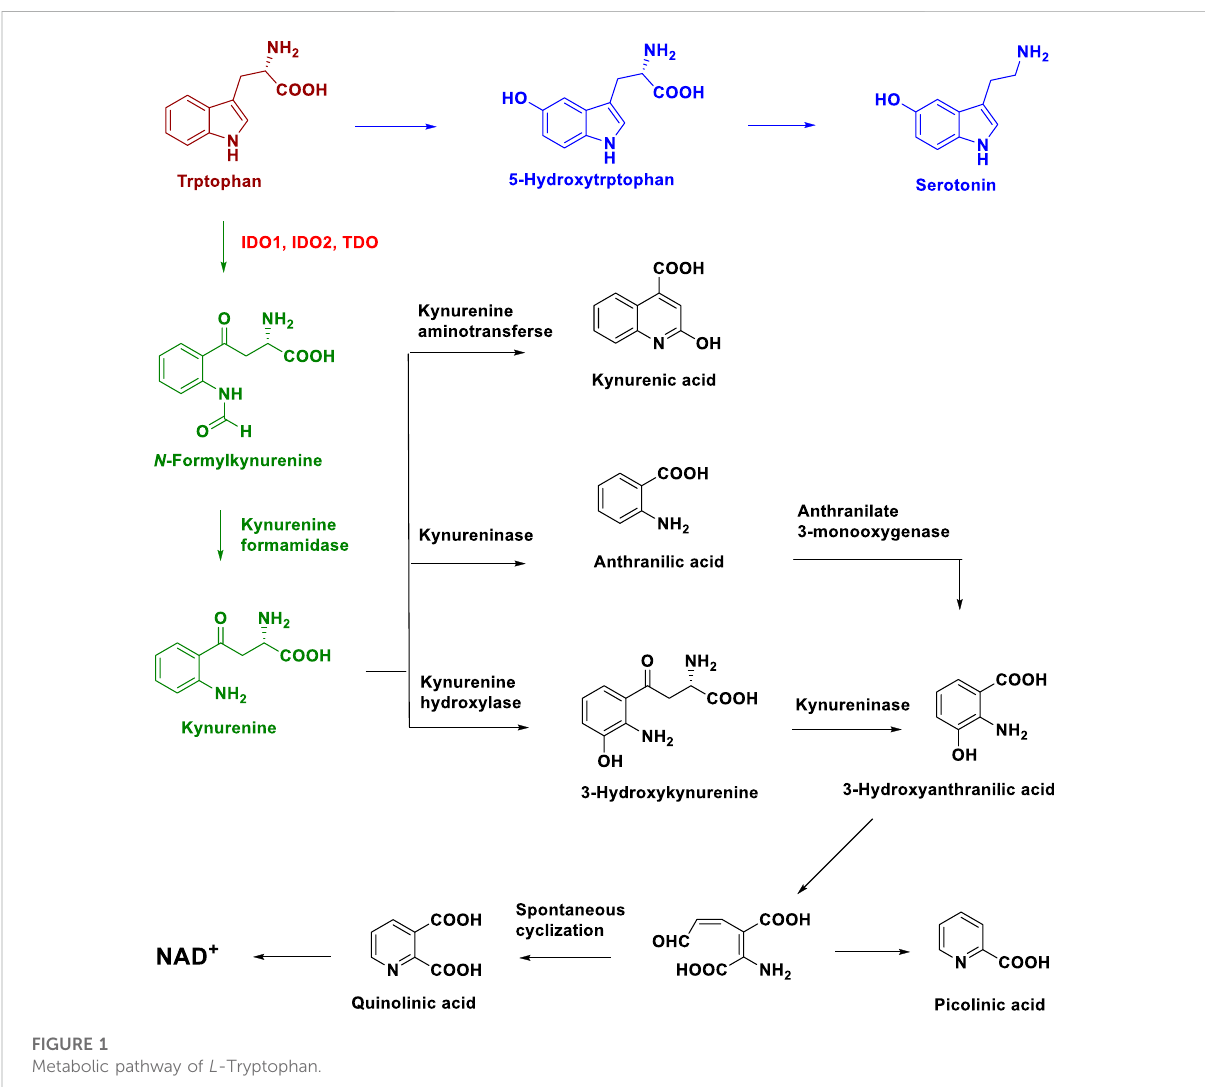
FIGURE 1 Metabolic pathway of L